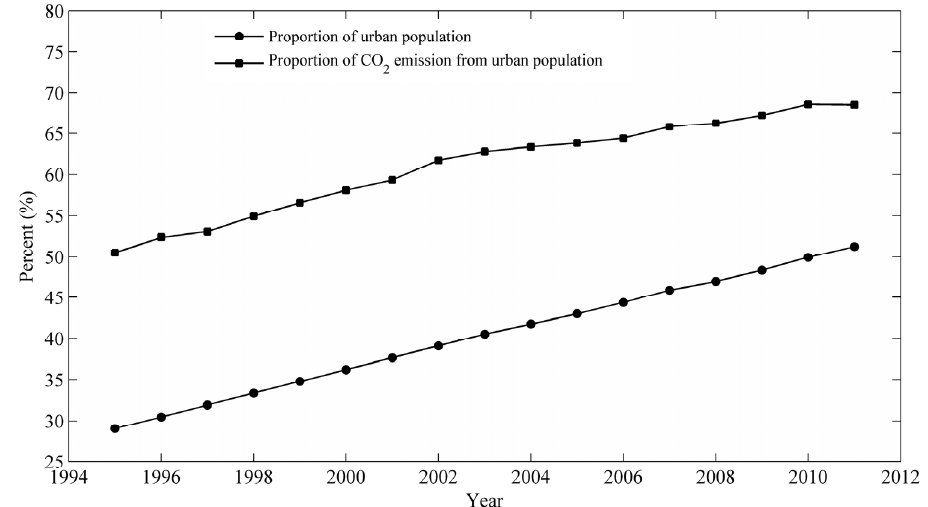
Figure 4. Proportion of urban population and their share to the total HCEs (in